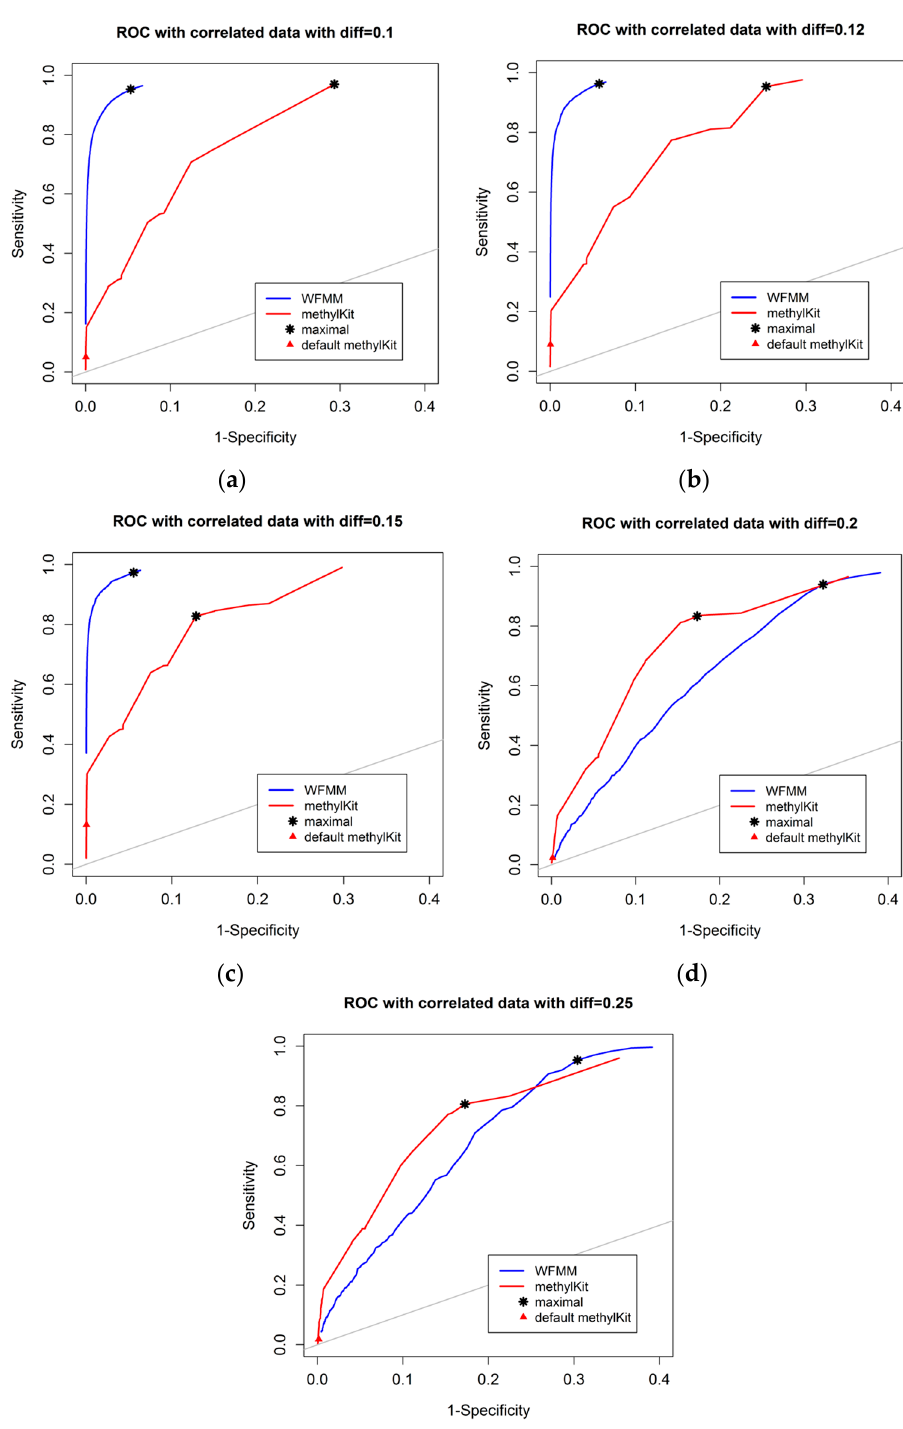
Figure 3. ROC curves of WFMM (blue curve) and methylKit (red curve) as differentially methylated cutoff increases from 0.1, to 0.25 (diff = 0.1, 0.12, 0.15, 0.2, 0.25).